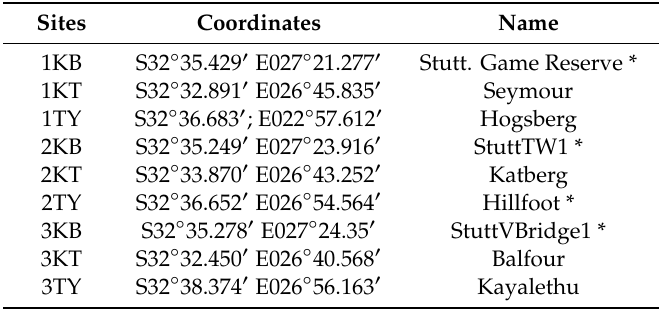
Table 1. Coordinate and name descriptions of the sampling